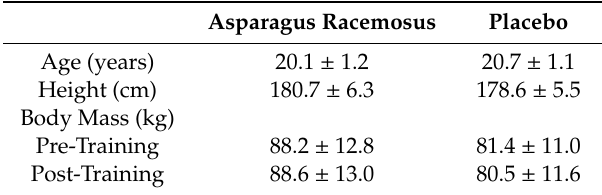
Table 1. Participant